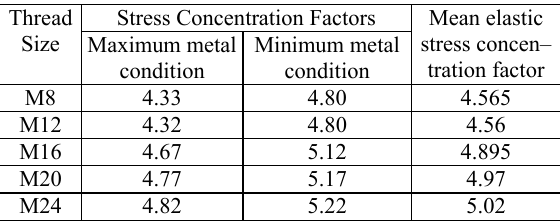
Table 1. Summary of elastic stress concentration factors. Thread